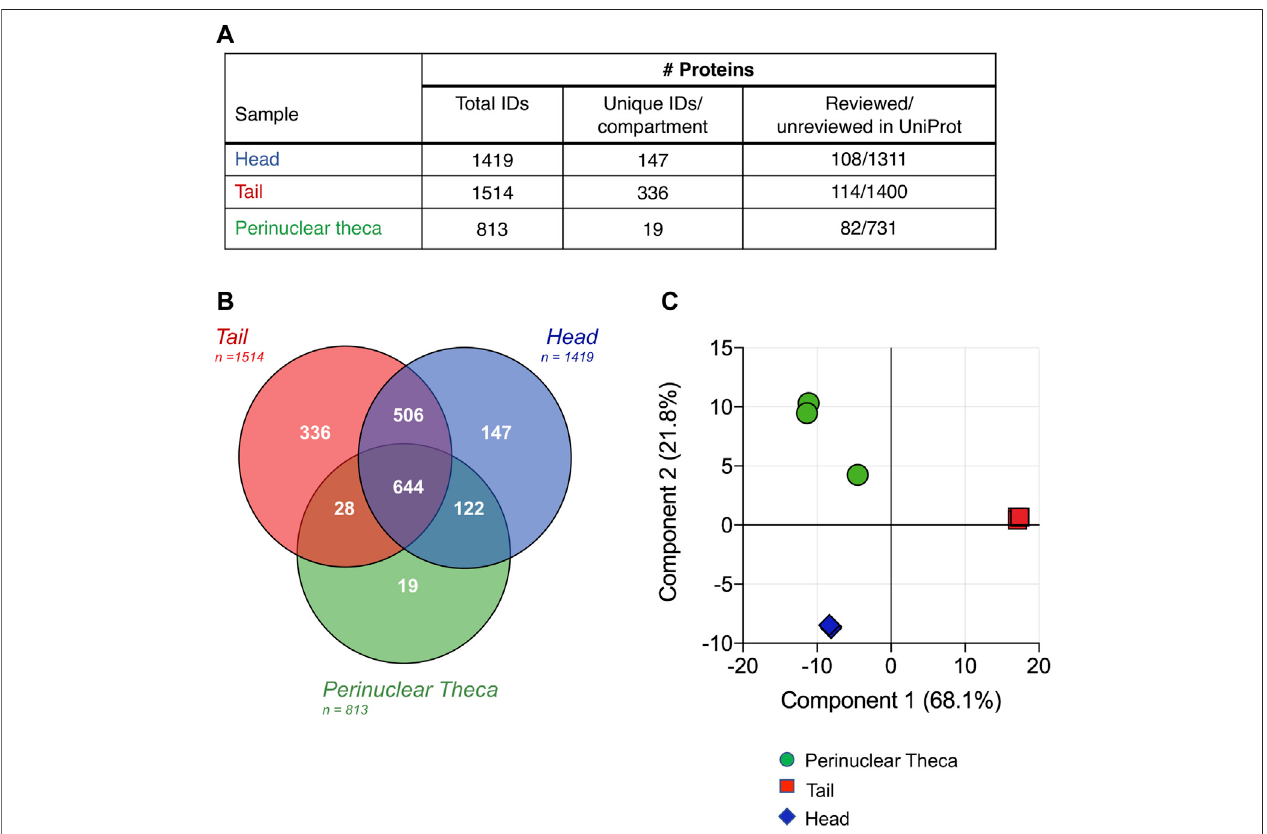
FIGURE3| Characterizationandcomparisonofboarspermhead,tailandPTproteincompositions. (A) Followingtherestrictionofeachproteomiclistbasedonthe presence of each protein in all three replicates and strict quality control cutoffs, analysis of the head, tail and PT proteomes revealed 1,419, 1,514, and 813 proteins, respectively.Duetothelimitedannotationofthe Susscrofa proteome,amajorityoftheproteinsfeaturedineachspermcompartmentheldan “ unreviewed ” statuswithin the UniProt database. (B) Proteins detected in each cell compartment were compared using a Venn diagram and principal component analysis (C) revealing the close clustering of biological